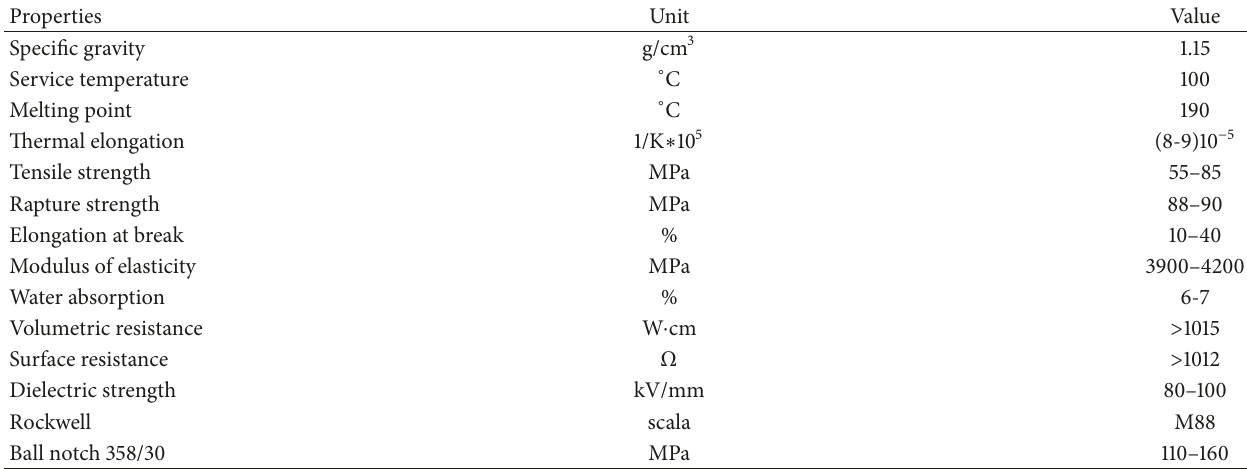
Table 1: The physical properties of the cast PA6G material.